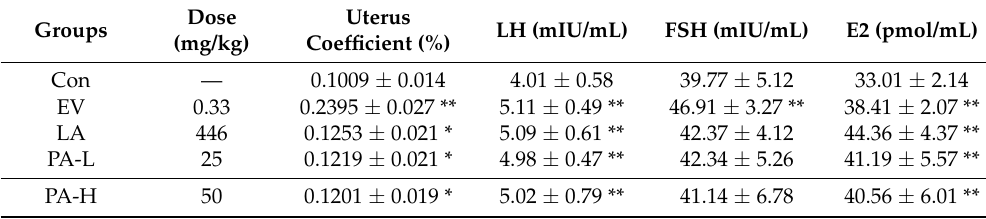
Table 2. Effect of PA on immature female Swiss mice ( x ± SD, n = 8).